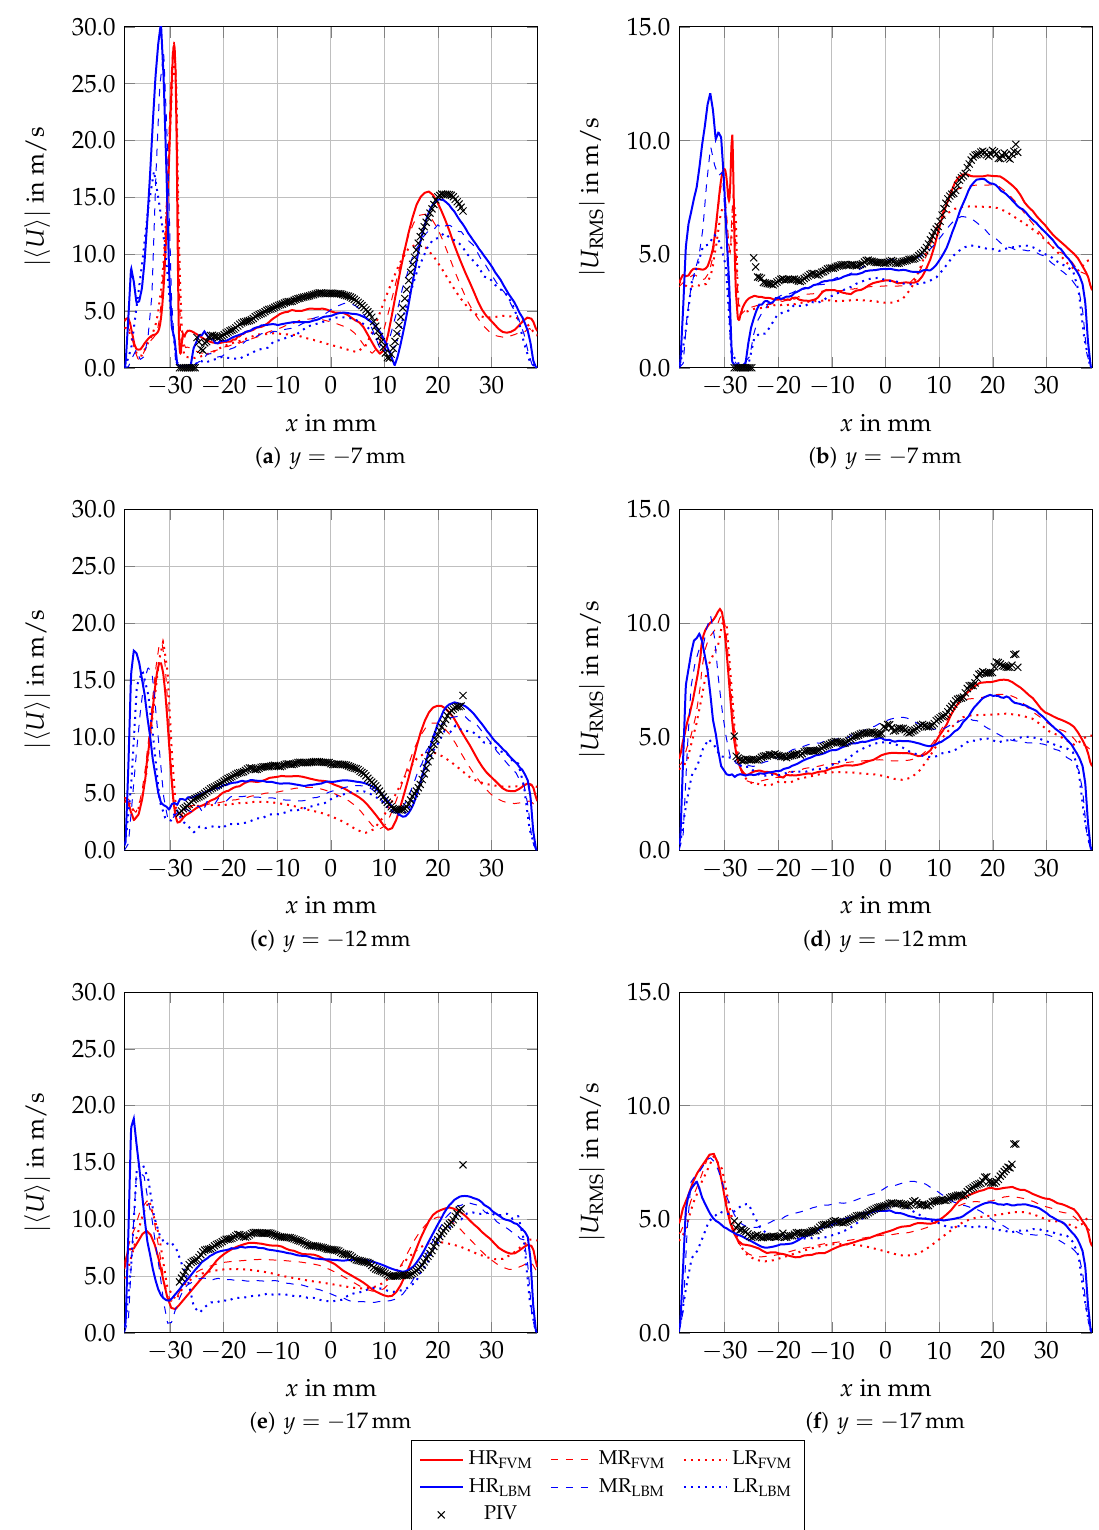
and root mean square (RMS) Figure 9. Magnitude of the two dimensional time-averaged velocity U |(cid:104) (cid:105)| velocity at y = 7mm, y = 12mm and y = 17mm in low, medium and high resolution U RMS − − − | | grids for Lattice Boltzmann Method (LBM) and finite volume method (FVM) in comparison with PIV